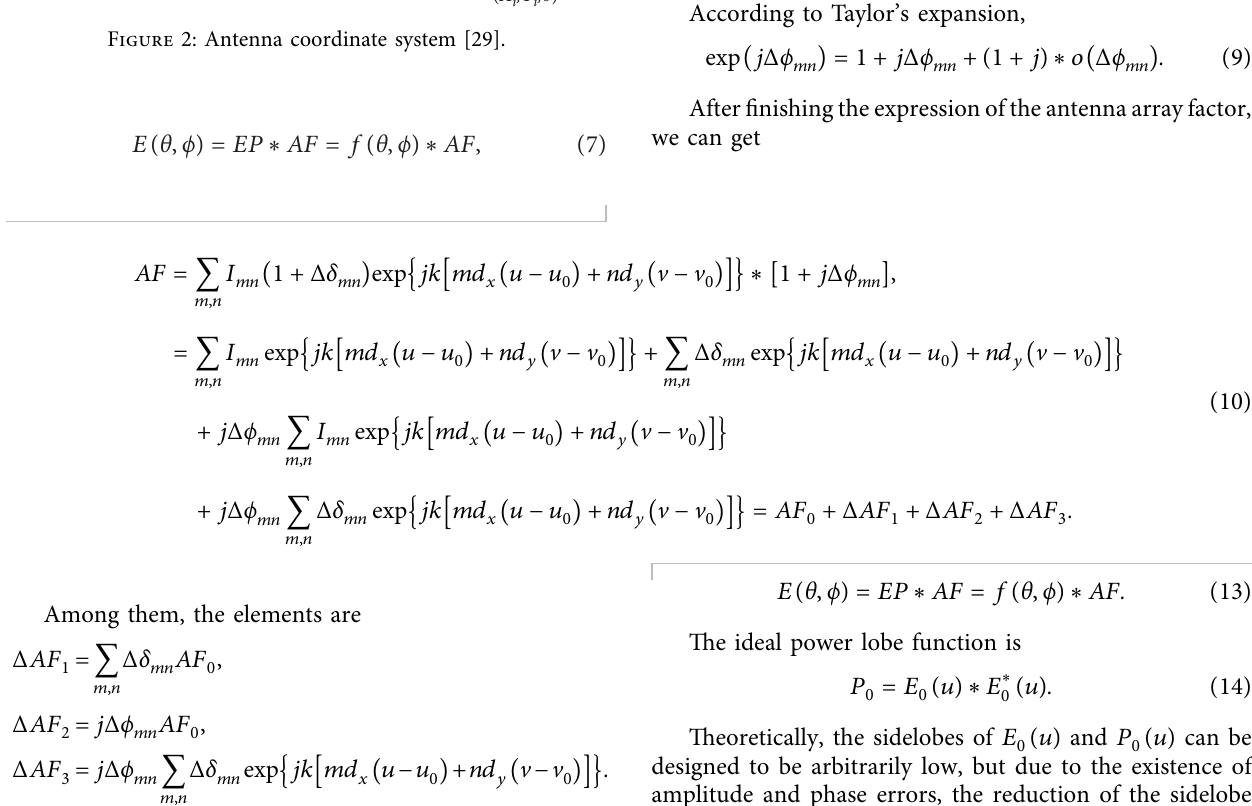
Figure 2: Antenna coordinate system